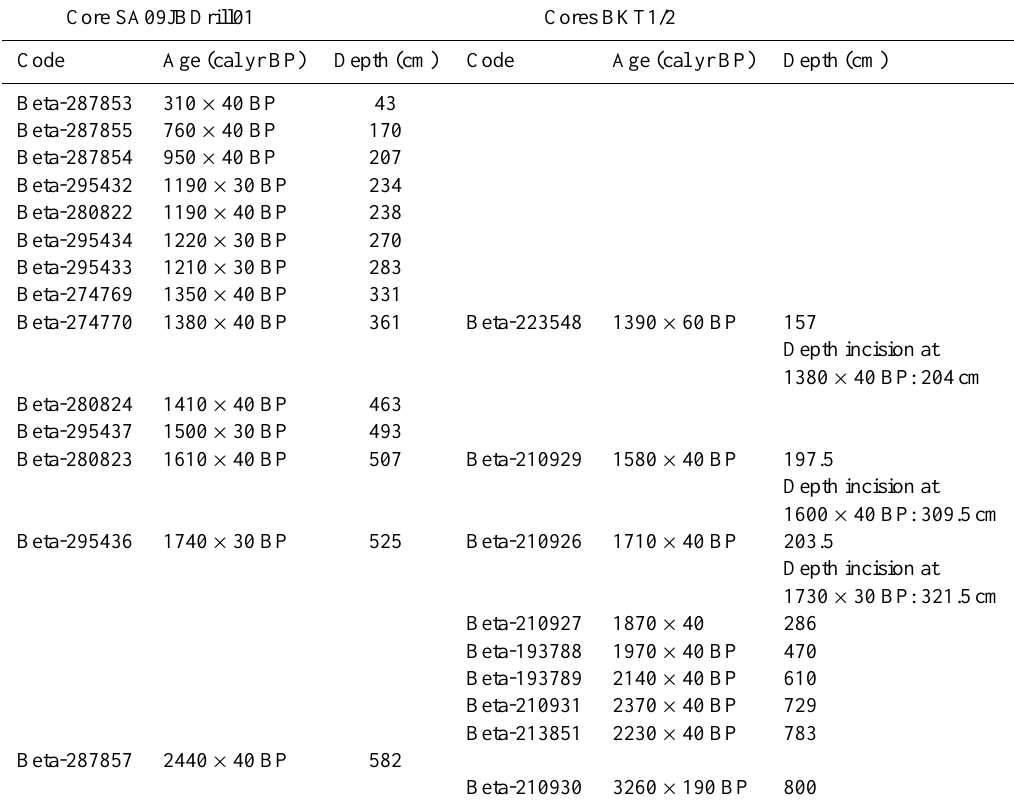
Table 5. Comparison of the well-dated age-depth curves of this core SA09JBDrill01 (Fig. 3) with core BKT1/2 (Fig. 2 of Kaniewski et al., 2007) evidence that deposits of an identical age are situated at greater depths in core SA09JBDrill01 compared to core